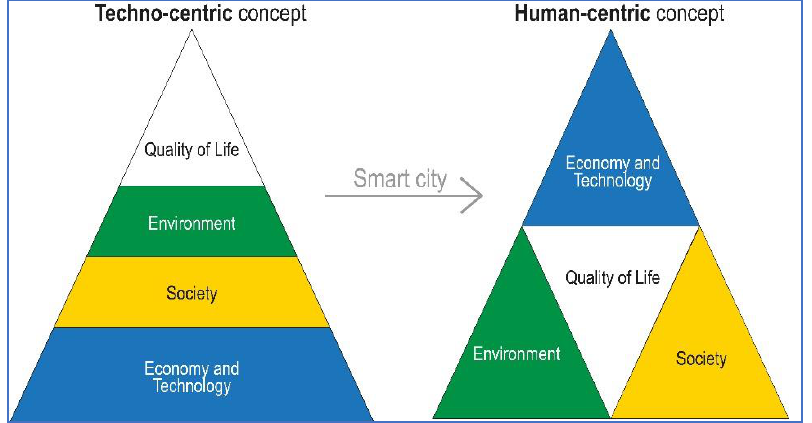
Figure 4. The concept of the smart city from the traditional techno-centric conception to a human-centric conception. Source: [9]. Adjusted by the author.